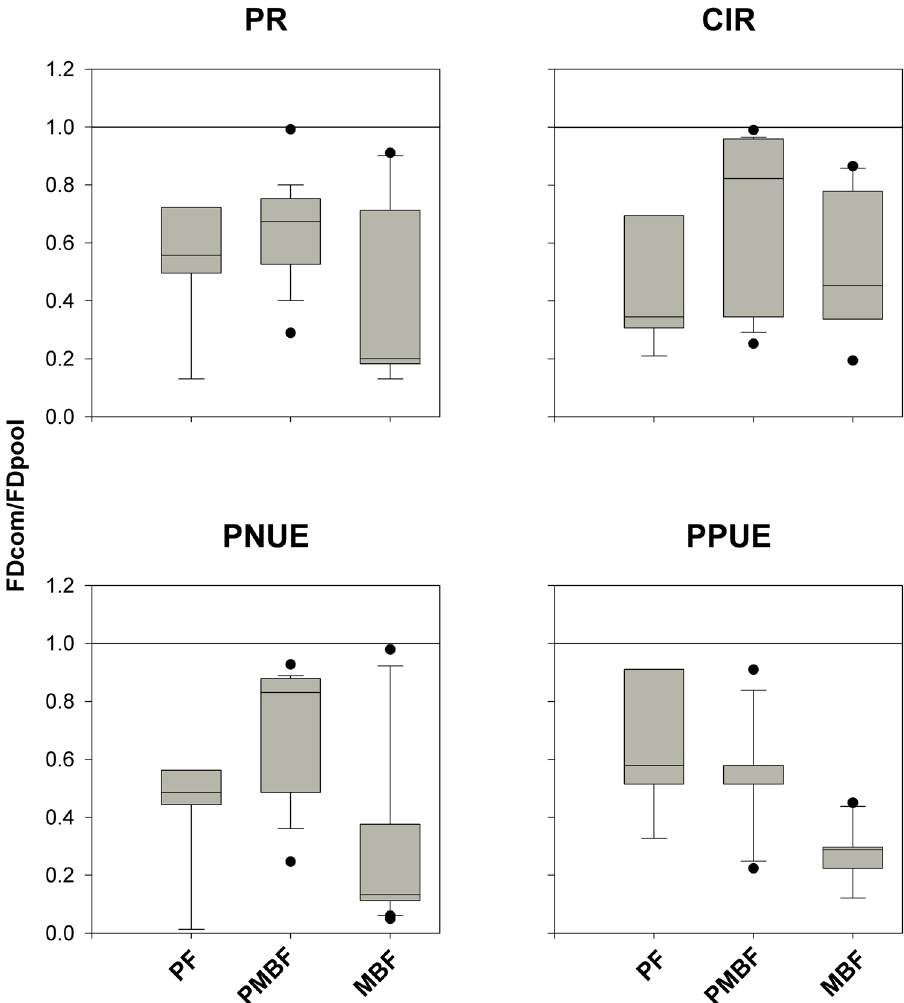
Figure 3. A boxplot showing the distributions of values of FDcom/FDpool ratio in three forest successional stages (Pine forest (PF), pine and mixed broadleaf forest (PMBF), and matured broadleaf forest (MBF)). FDcom/FDpool > 1 represents strong competition exclusion, FDcom/FDpool < 1 indicates exclusion of weak competitors, and FDcom/FDpool = 1 implies random biotic interaction. The solid line inside the box represents the median of the data. The bottom and top of the box represent the 1st quartile and 3rd quartile of the data, respectively. The vertical lines extending from the box represent the data inside a range of 1.5 times the interquartile range from the box. An outlier is denoted by filled